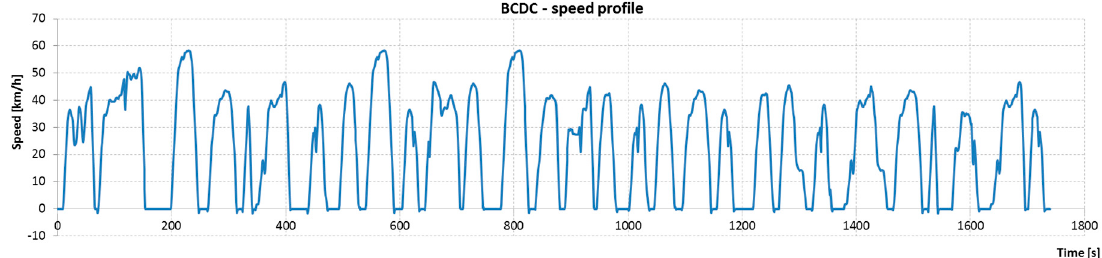
Figure 20. BCDC driving cycle.